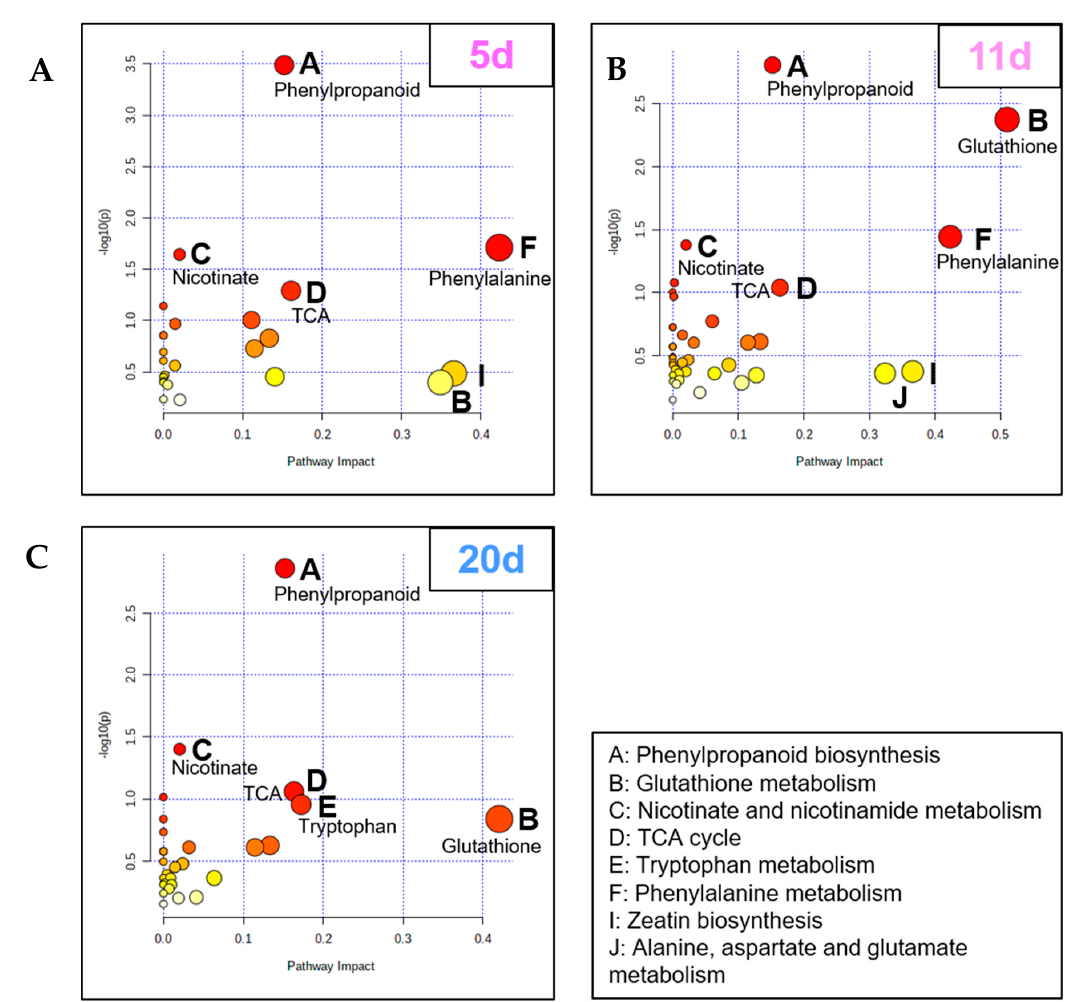
Figure 6. Metabolomic Pathway Analysis from leaves of B. napus exposed to 5 d (mild) ( A ), 11 d (severe) ( B ), and 20 d (severe and extended) ( C ) of water deficit relative to control plants. Pathways are displayed as circles whose coordinates correspond to their adjusted p -value expressed in − log10( p ) (for example, p < 0.05 corresponds to − log10( p ) > 1.3) and their impact. For easier reading, low to high p -values are displayed with a white-yellow-orange to red gradient, with white representing the lowest values and red representing the highest; the size of the circle corresponds to the pathway impact score. Only the most impacted pathways having high statistical significance scores (-log10( p ) > 1.3) or pathway impact (>0.15) are identified.